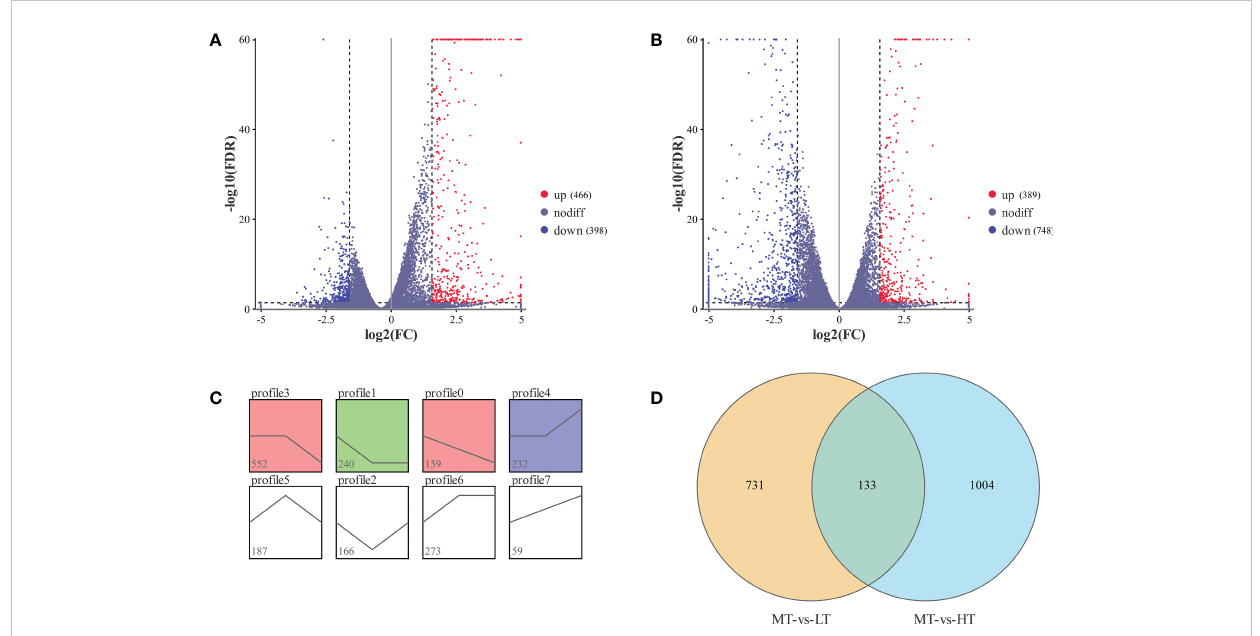
FIGURE 2 Overview of DEGs in G . bailinae exposed to different temperatures. (A) Volcano plots of the DEGs in MT vs LT. (B) Volcano plots of the DEGs in MT vs HT. (C) Trend analysis of DEGs in MT vs LT and MT vs HT. Signi fi cant enrichment trends are shown by colored blocks ( P < 0.05). The bottom-left number represents the number of genes. (D) Venn diagram depicting the number of DEGs obtained in the MT vs LT and MT vs HT